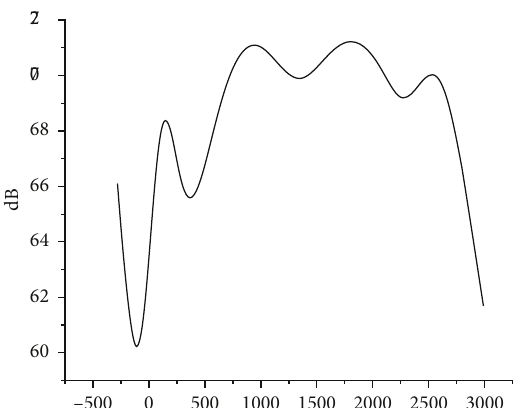
Figure 1: The impact curve of the floor slab of an ordinary res- idential district (mao embryo house).